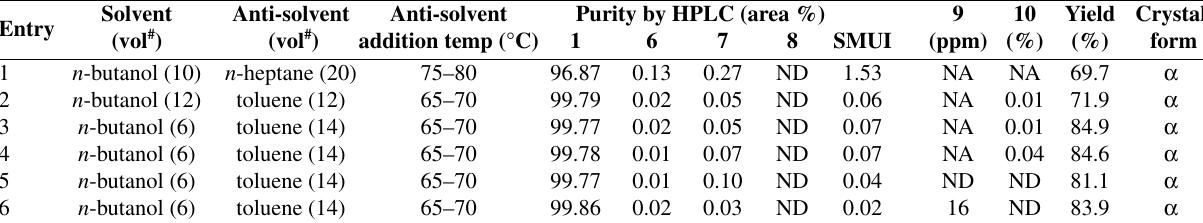
Table 2. Optimization results of anti-solvents with n -butanol with respect to their volumes, impurity profile and yields of α -form crystals. Solvent